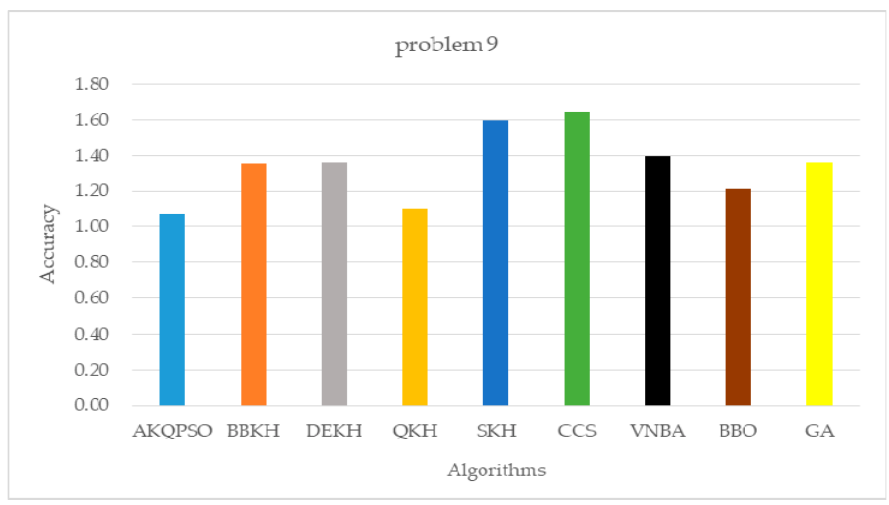
Figure 10. Accuracy of AKQPSO and other algorithms on problem 8: expanded Schaffer’s F6 function.